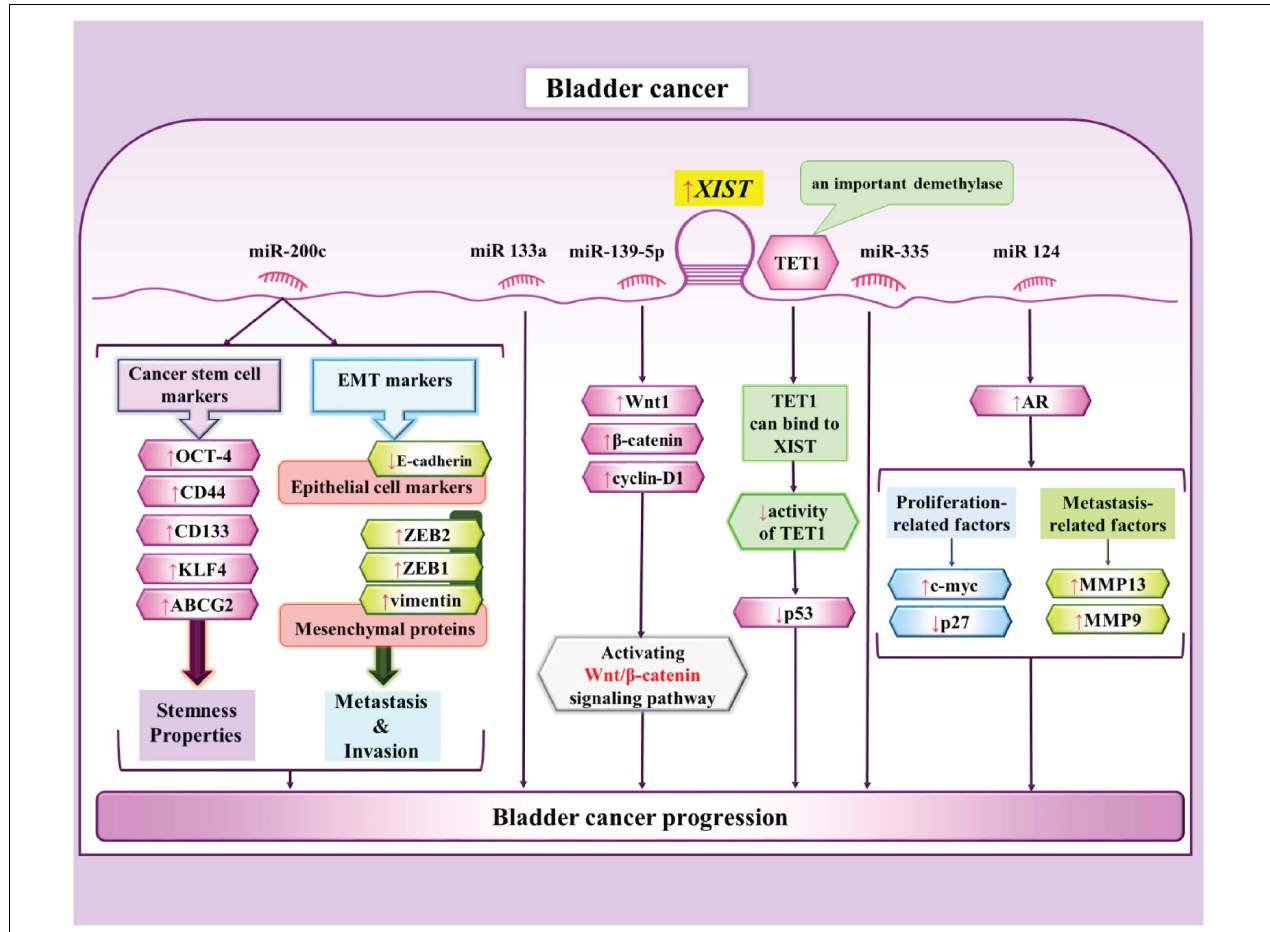
FIGURE 5 | The interactions between XIST and miRNAs in bladder cancercells (Hu et al., 2017, 2019; Xiong et al., 2017; Xu et al., 2018; Zhou et al., 2019b). XIST influences progression of bladder cancer through suppressing p53 via binding to TET1 (Hu et al., 2019). Another route of participation of XIST in tumor growth and metastasis is exerted through regulation of miR-139-5p and Wnt/ β -catenin pathway (Hu et al.,